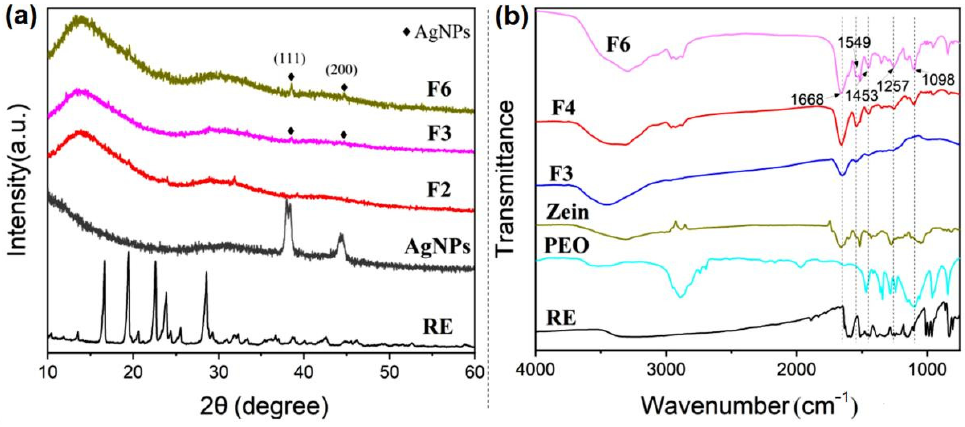
Figure 6. Physical status and compatibility of antibacterial nanofiber membranes: ( a ) XRD analysis; ( b ) FT-IR spectra.